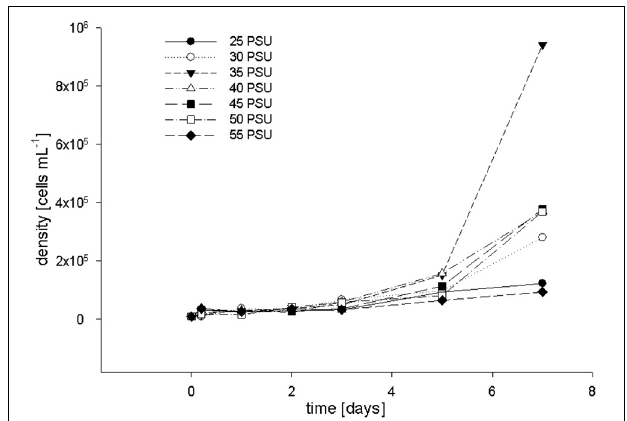
FIGURE 6 | Average effective PSII quantum yields ( (cid:2) F / F m (cid:2) ) from corals at each station over a 29-day exposure period. Bars show average PAR values for each sampling event. Error bars represent standard deviation, dashed lines indicate (cid:2) F / F m (cid:2) range from control coral colonies measured in their natural